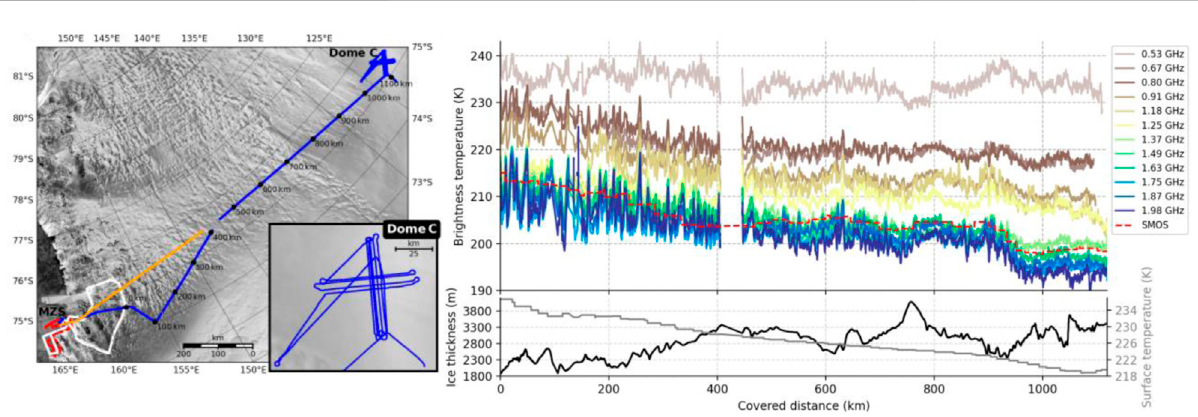
FIGURE 9 (left) UWBRAD transects over Terra Nova Bay and Northern Victoria Land Antarctica in 2018. The two coastal and Terra Nova Bay Antarctic fl ights are shown in white and red. The fl ights to and from Concordia Station are shown in blue and yellow along with an enlargement around Concordia Station (right) Twelve-channel UWBRAD brightness temperature (K) along the fl ight from the coast to Dome C; SMOS observations are the red dotted line; (bottom of fi gure) the ice thickness (black, left axis) and surface temperature (grey, right axis) (From Brogioni et al., 2022a).